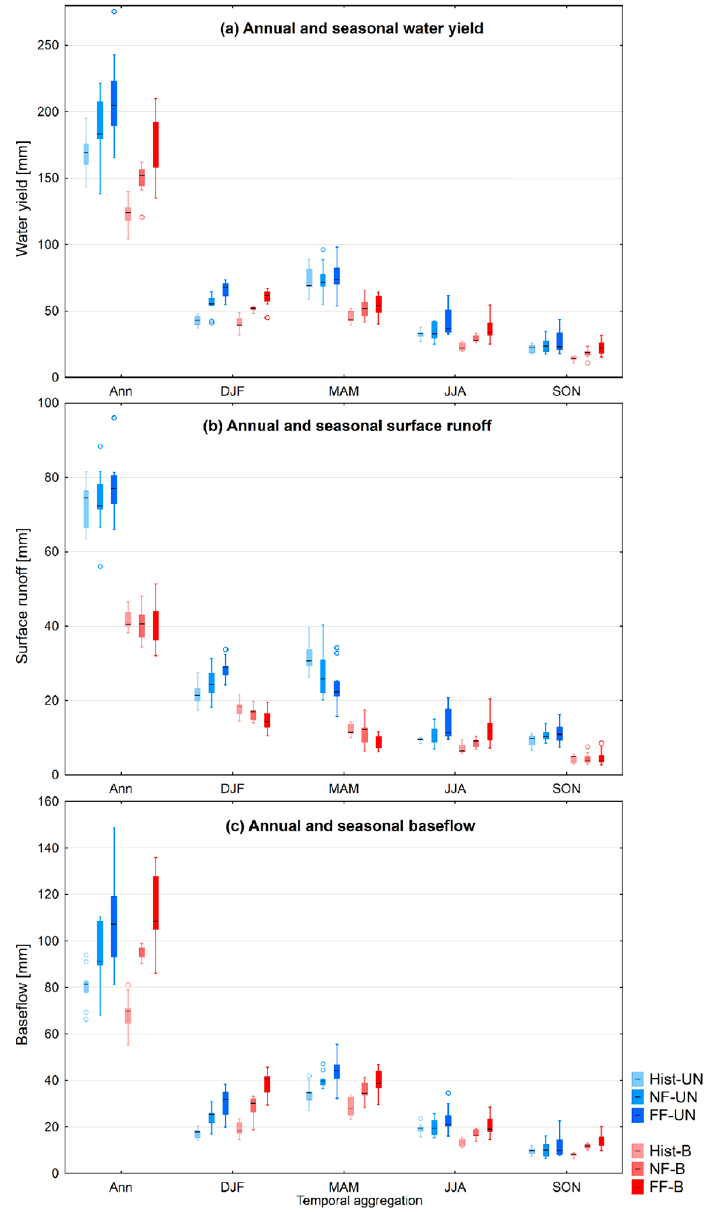
Figure 9. Multi-model ensemble projections of annual and seasonal water yield ( a ) and its two major components, surface runoff ( b ) and baseflow ( c ), for the near (NF) and the far (FF) future under RCP 4.5 in comparison to the historical (Hist) period. B stands for the Barycz catchment and UN stands for the Upper Narew catchment.